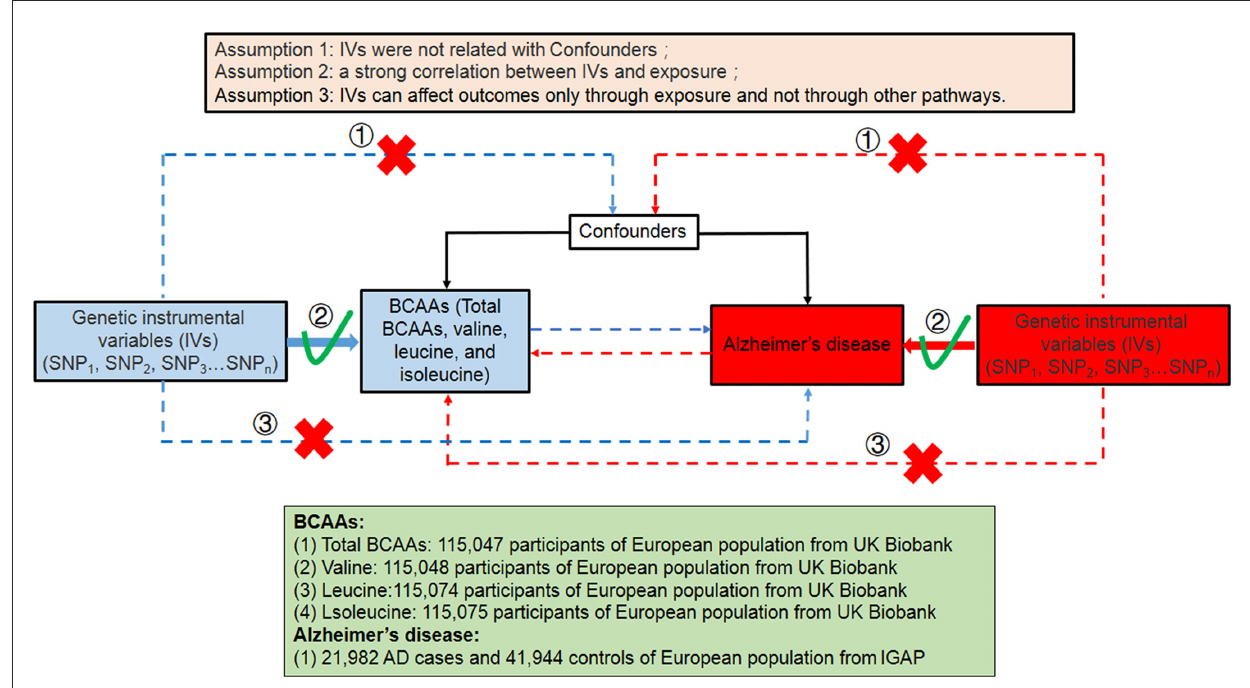
FIGURE1 Summary of this bidirectional MR study between the level of BCAAs and the risk of AD in this study. SNP, single-nucleotide polymorphism; BCAAs, branched-chain amino acids; AD, Alzheimer’s